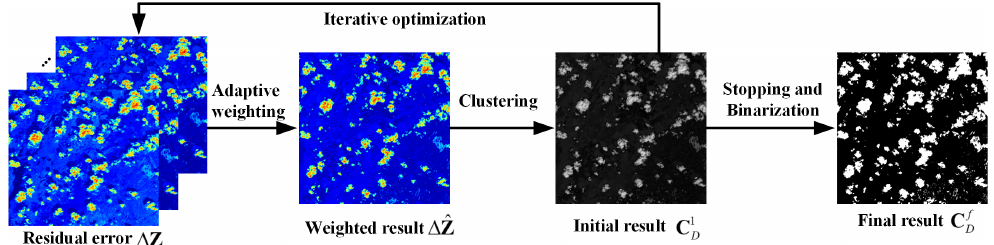
Figure 3. Detailed description of the proposed iterative optimization